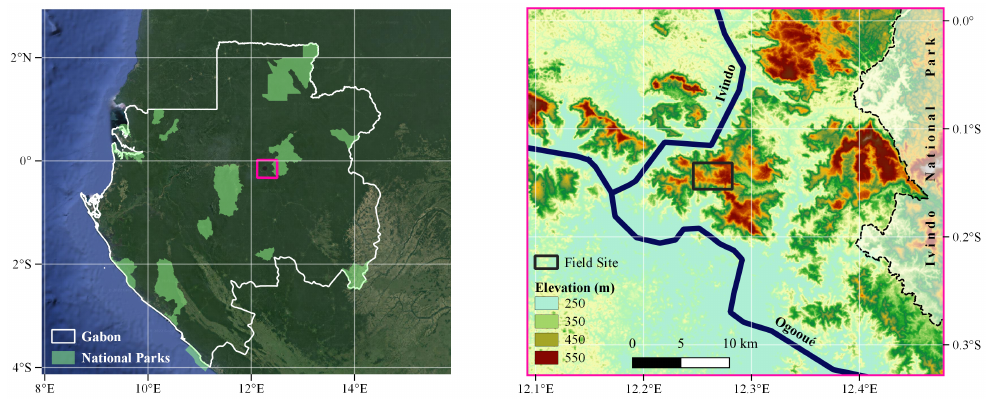
Figure 1. ( left ) Gabon is situated on the west coast of equatorial Africa and is densely forested, with around 10% of this forest protected by National Parks. The location of the inset map is shown in pink; ( right ) location of our field site (black box) in the Ogooué-Ivindo department, showing large rivers (dark blue) and